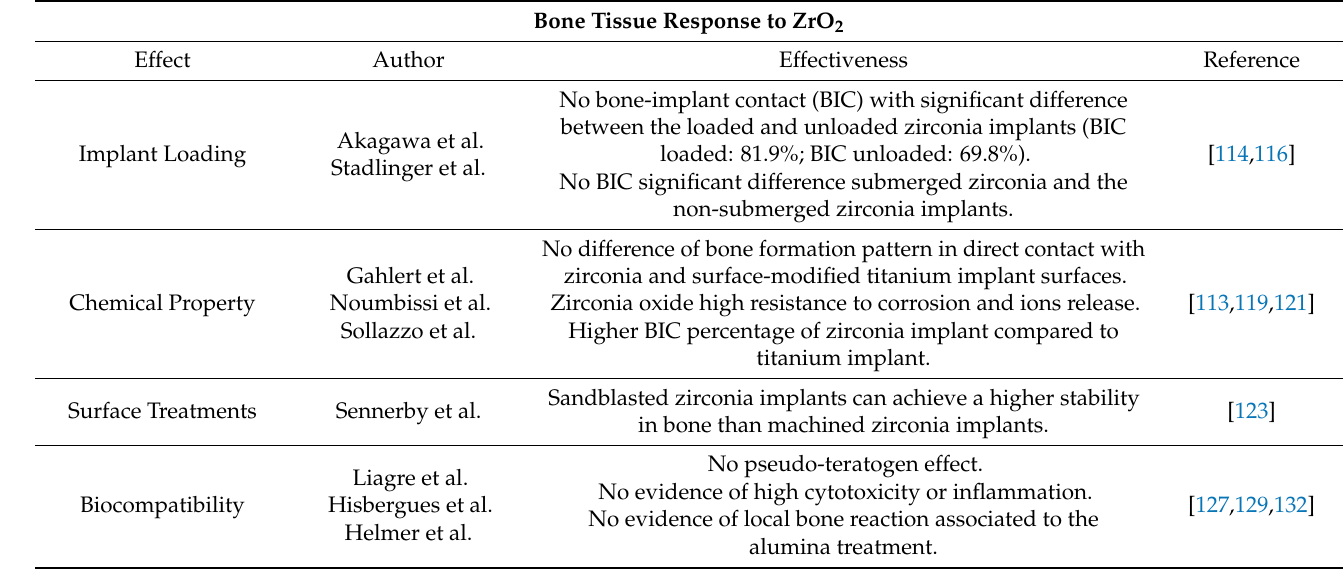
Table 3. Summary of the hard tissues’ response of the ZrO 2 -based materials. Bone Tissue Response to ZrO